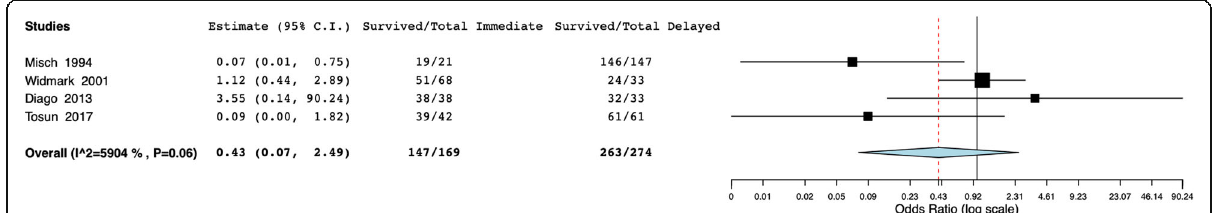
Fig. 6 Comparison of implant survival between simultaneously placement and delayed placement of implants with onlay bone grafts